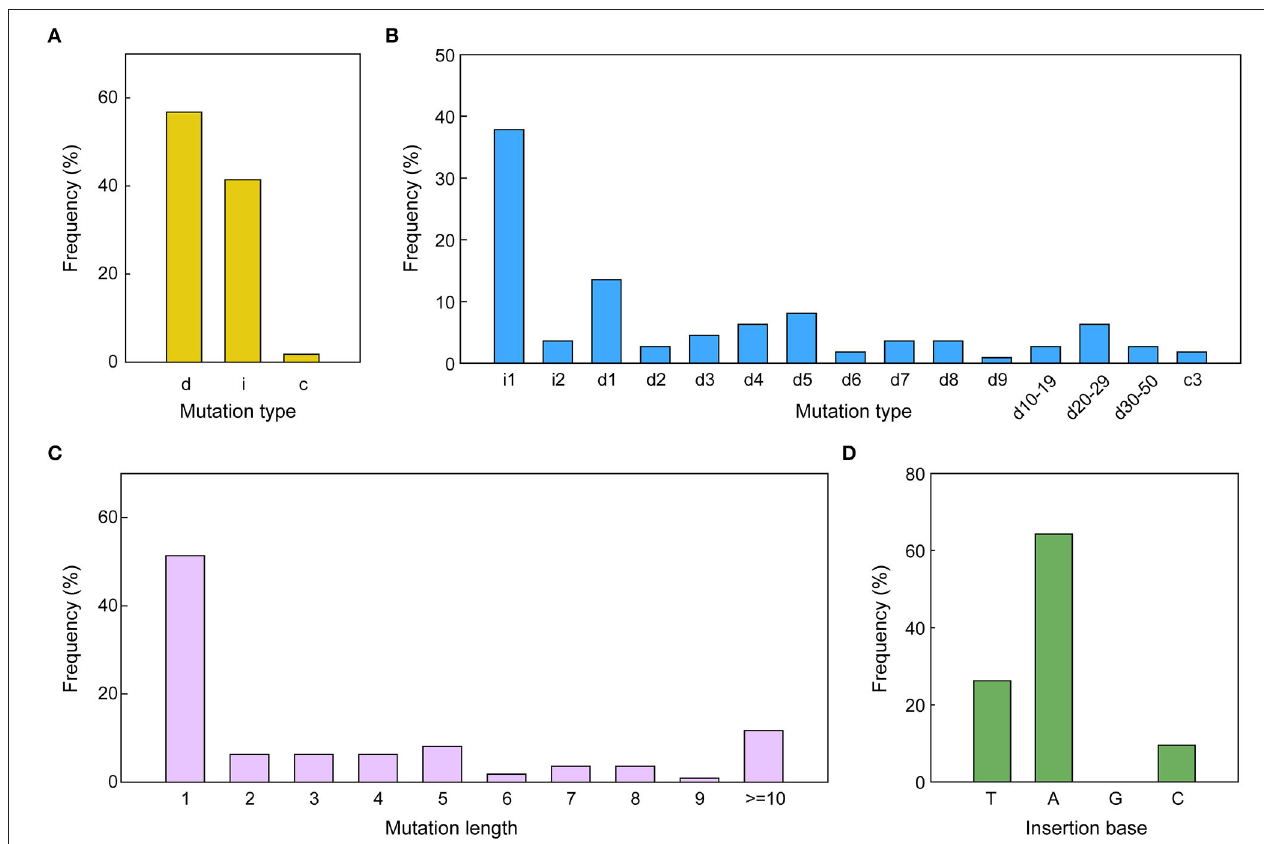
FIGURE 5 | CRISPR/Cas9-triggered mutation types along with frequency in sesame. (A,B) Mutation kinds along with the frequency of all mutations induced by the two different sgRNAs. i, insertion; c, combined mutation; d, deletion. i#, number of bp inserted at the target site; d#, number of base pairs (bp) deleted from the target site; c#, number of bp combined mutations. (C) The frequency of various mutation lengths irrespective of the mutation type. (D) Percentage of bases inserted for the 1-bp insertions. A, adenine; C, cytosine; T, thymine; G, guanine.